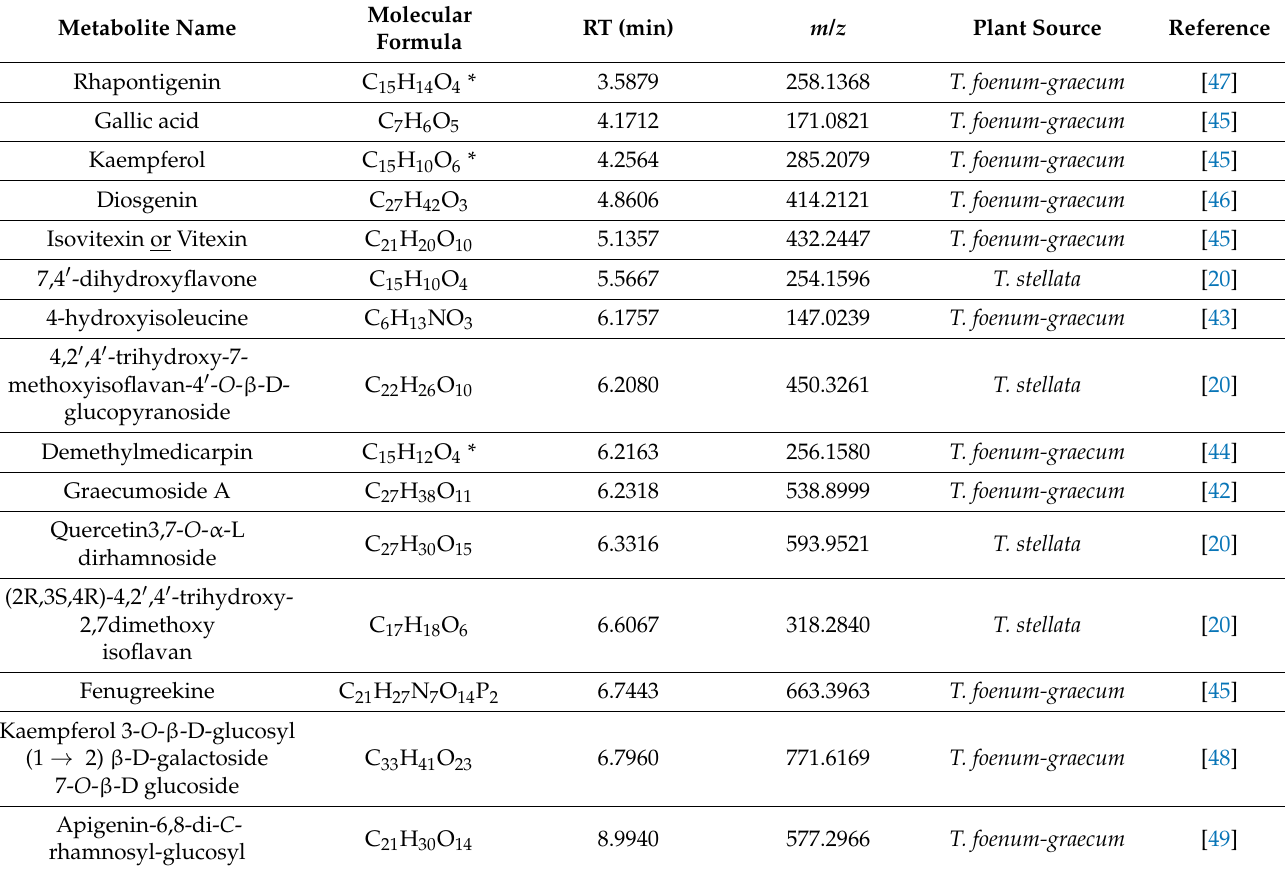
Table 1. The LC-HRESIMS dereplication results of Trigonella stellata methanolic extract.